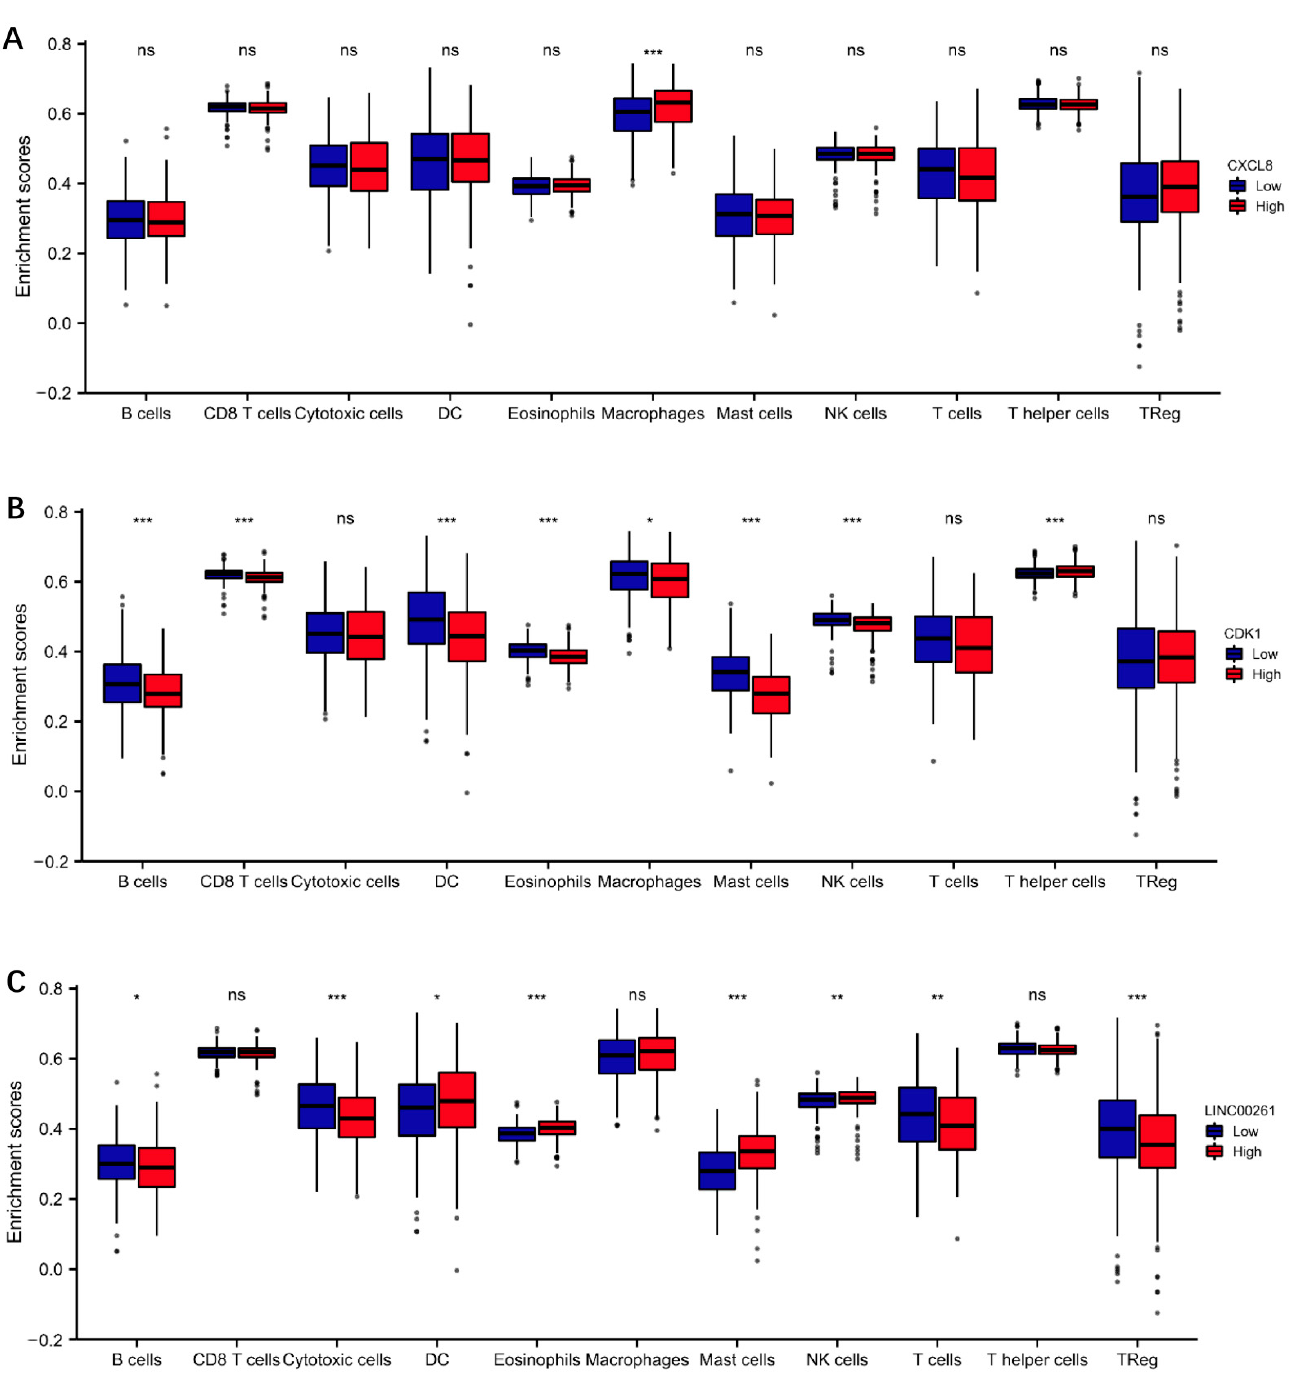
Figure 5. Immune infiltration analysis. ( A ) CXCL8. ( B ) CDK1. ( C ) LINC00261. Significance